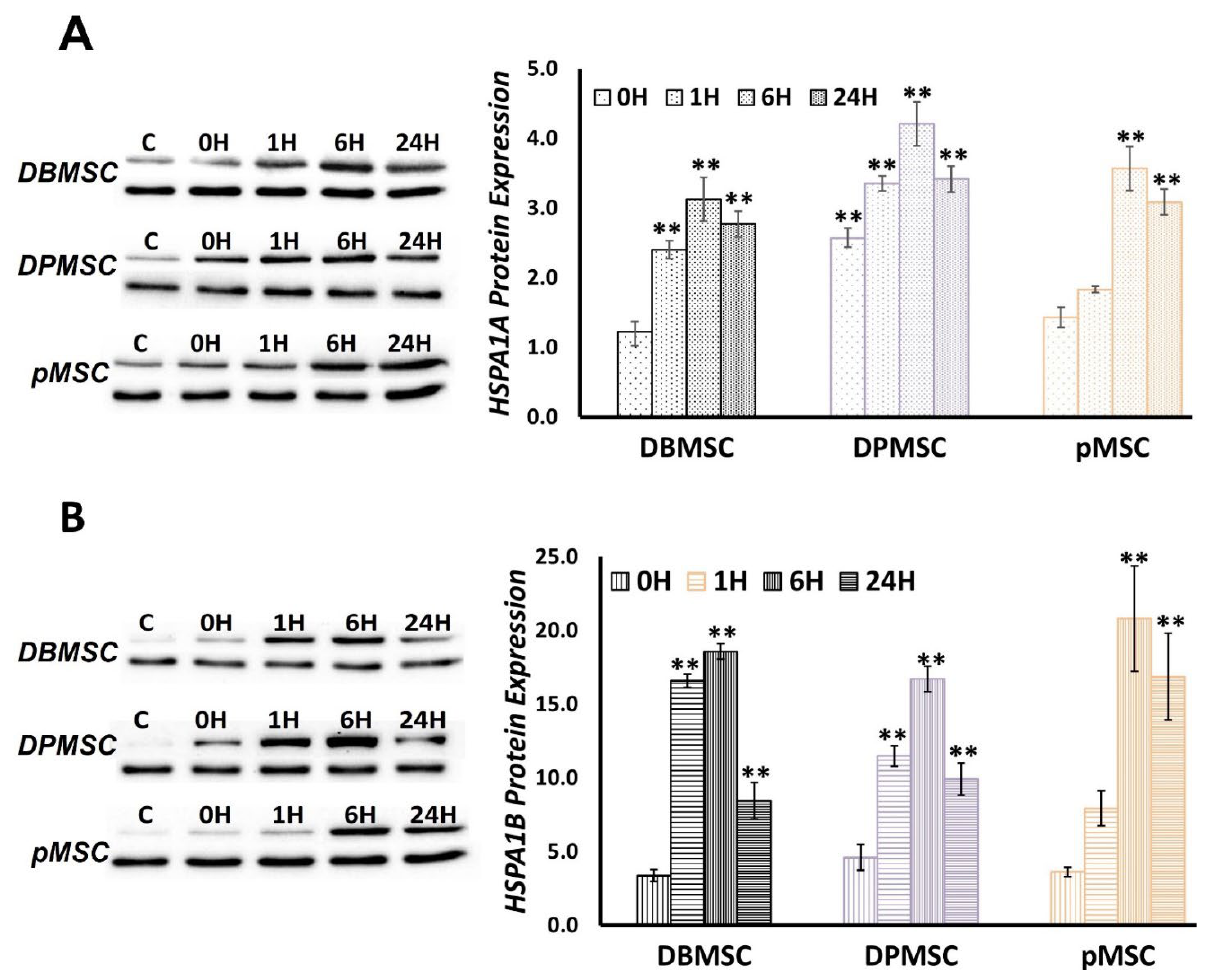
Figure 7. ( A ) HSPA1A and (B) HSPA1B protein expression in DBMSC, DPMSC and pMSC, immedi- ately at commencement of heat stress (0H) and during recovery at 37 ◦ C at 1 h (1H), 6 h (6H), and 24 h (24H). More HSPA1A ( A ) in control samples as compared to HSPA1B ( B ). Protein expression is reported to be statistically significant ** at p -values < 0.05.